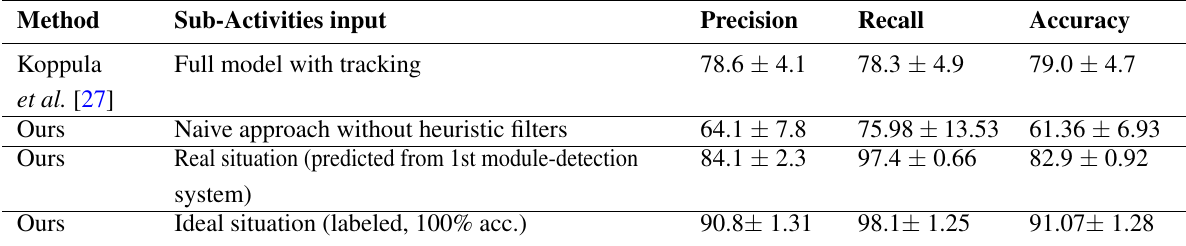
Table 14. Comparison of our approach with the dataset’s algorithm.